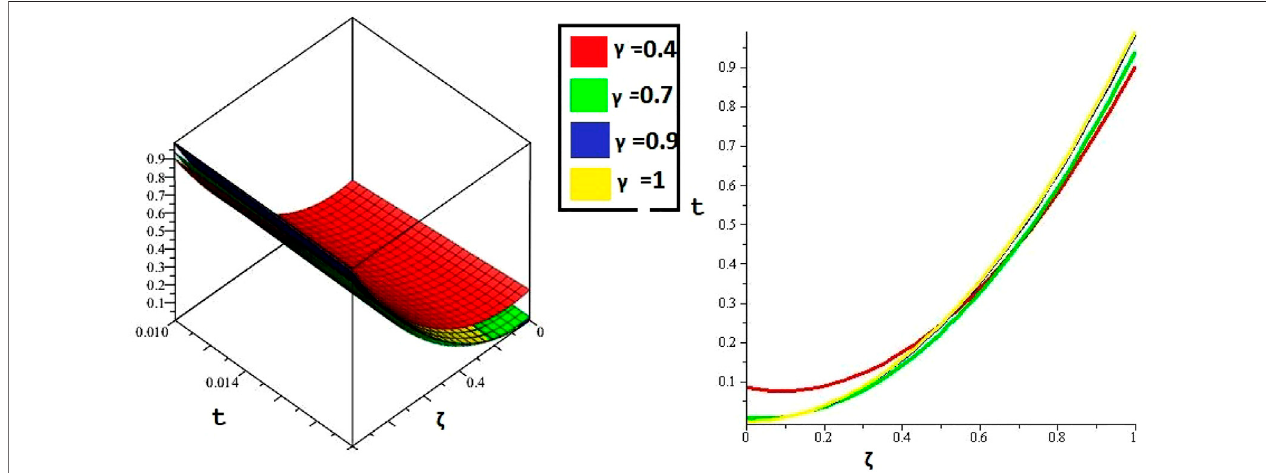
FIGURE 4 | 3D and 2D plots for the ADM solution at different values of γ for Example 1.